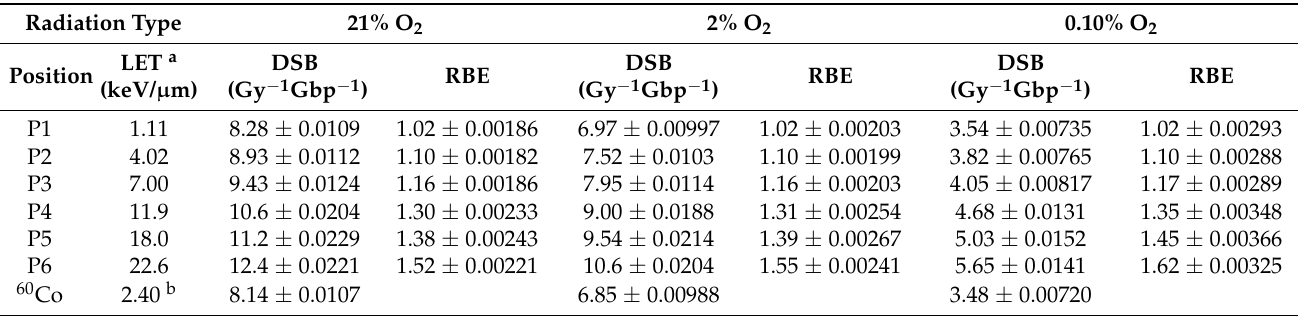
Table 3. The absolute yield of DNA damage (Gy − 1 Gbp − 1 ) and RBE induced by 60 Co. γ -rays and a 62 MeV proton beam under oxygen concentrations 21, 2, and